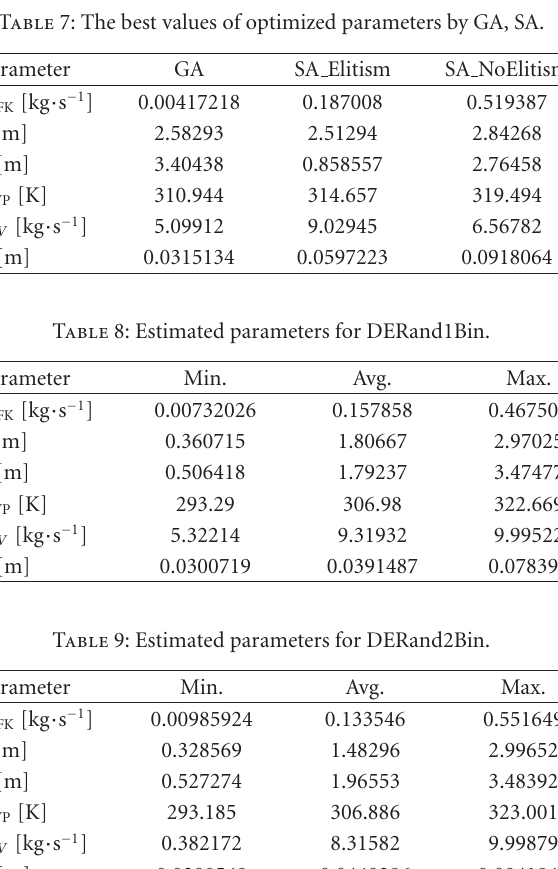
Table 5: Optimized reactor parameters and their range inside which optimization has been done.